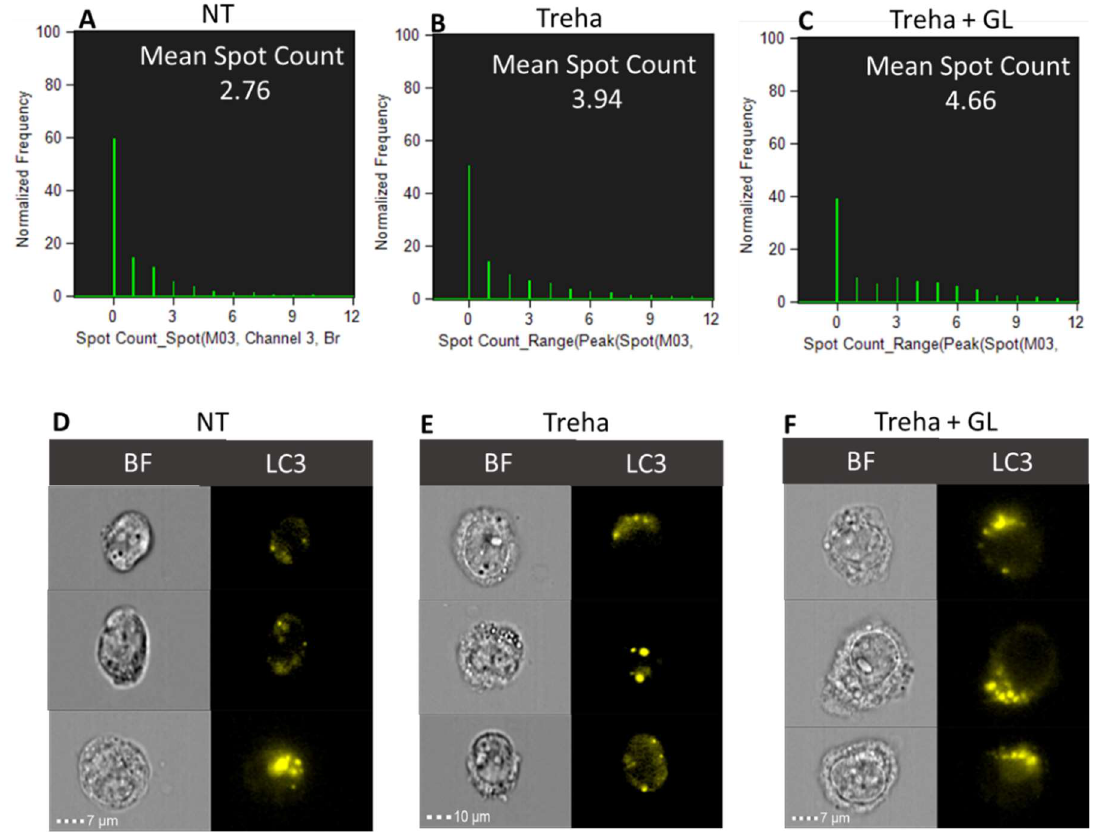
Figure 11. LC3 Spot-count histograms and cells galleries. The spot-count feature Spot Count_Range(Peak(Spot(M03,Ch3-LC3-AF555,Bright,7,3),Ch3,Bright,0) was used for NT ( A ), Treha ( B ), and Treha + GL ( C ). The mean spot counts for NT, Treha, and Treha + GL are 2.76, 3.94, and 4.66, respectively. Brightfield (BF) and LC3-AF555 (yellow) images of the cells are shown for NT ( D ), Treha ( E ), and Treha + GL ( F ). Event collected: 2000. The analysis was performed using Amnis ImageStream X Mark II (Merck).